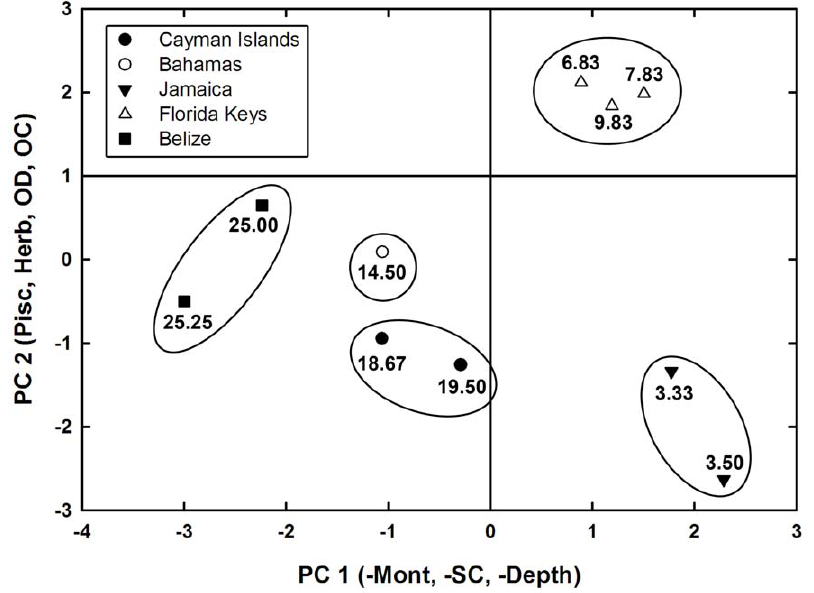
Figure 2. Scatterplot of site-scores on the first and second principal components. These two axes represent 73.4% of the total variation in the correlation matrix. Independent variables listed on each axis indicate variables with significant eigenvector loadings. Abbreviations for variables are listed in Table 2. Mean S. planifrons densities are given for each site ( n =6 transects per site).